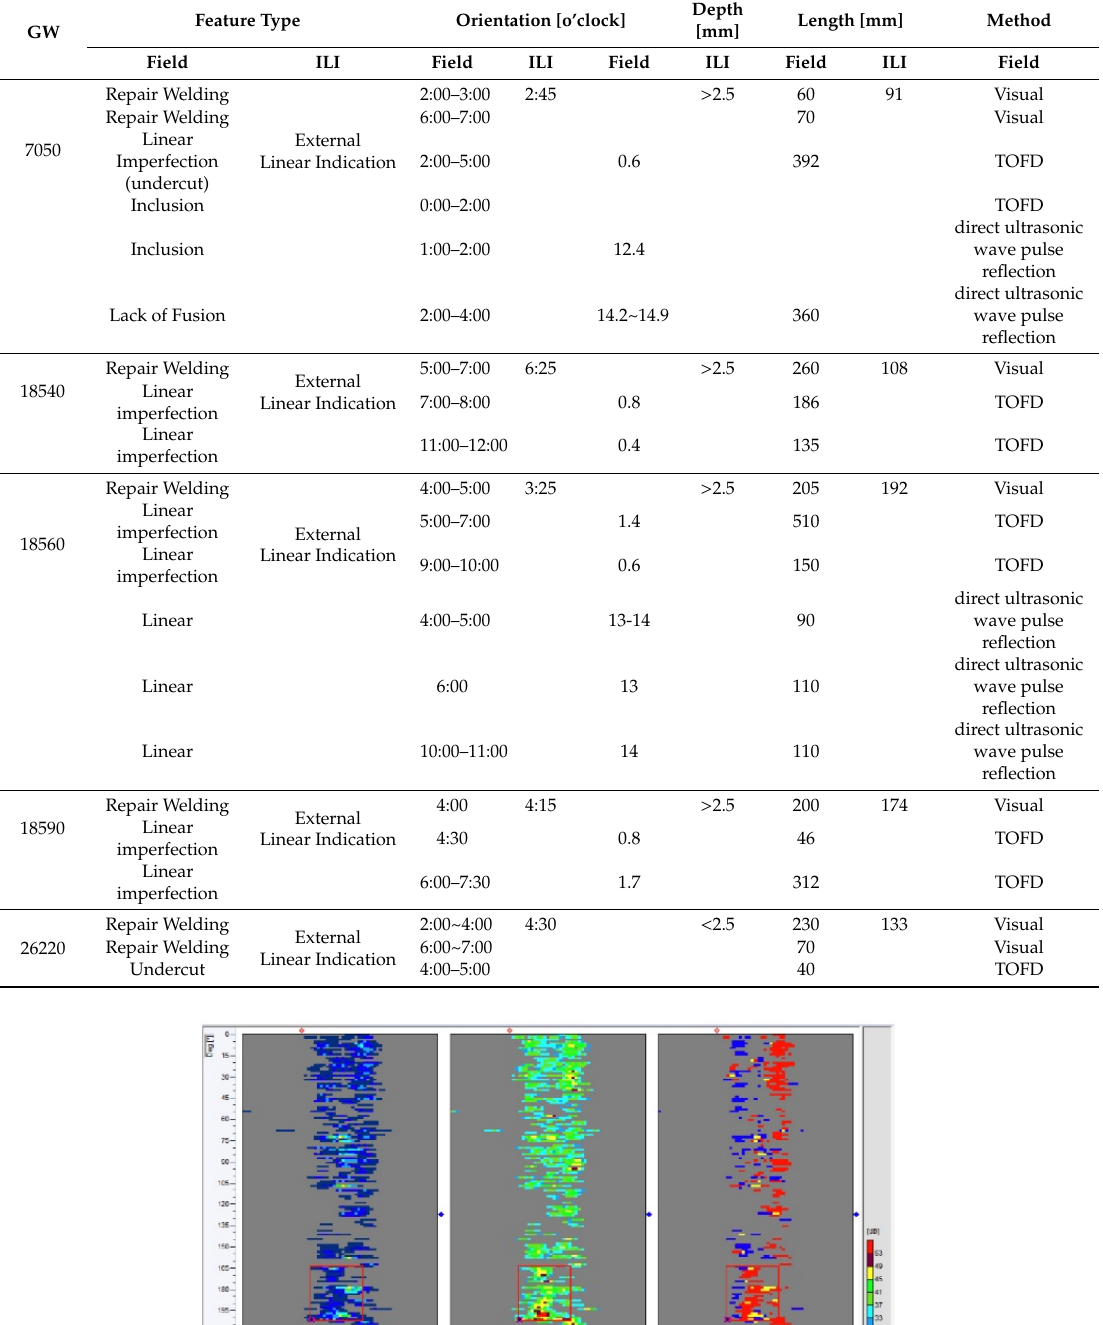
Table 6. Excavation results of the first five digs.